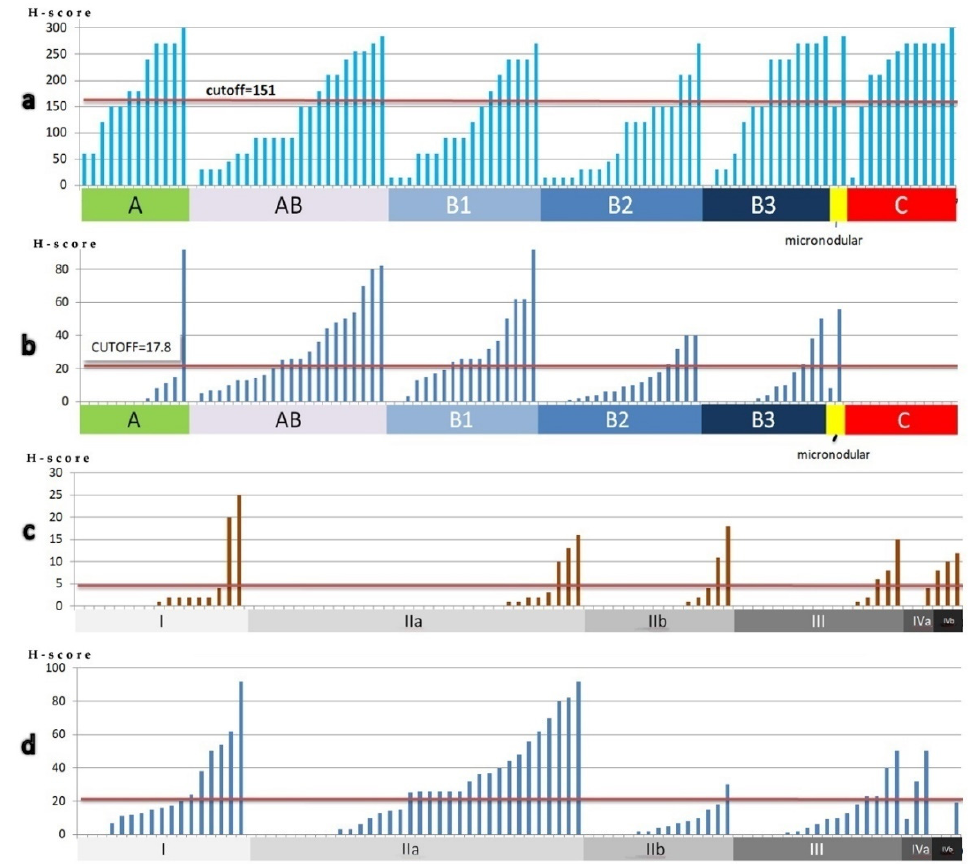
Figure 5. There is higher lymphocytic EphB1 H ‐ score in thymic carcinomas ( a ) and higher lymphocytic EphB6 H ‐ score in subtypes A and AB, but no EphB6 expression in thymic carcinomas ( b ). Lower epithelial ( c ) and higher lymphocytic ( d ) EphB6 H ‐ scores correlate with Masaoka stage < II. Each bar represents one case. Cases were arranged by increasing H ‐ score in each diagram.